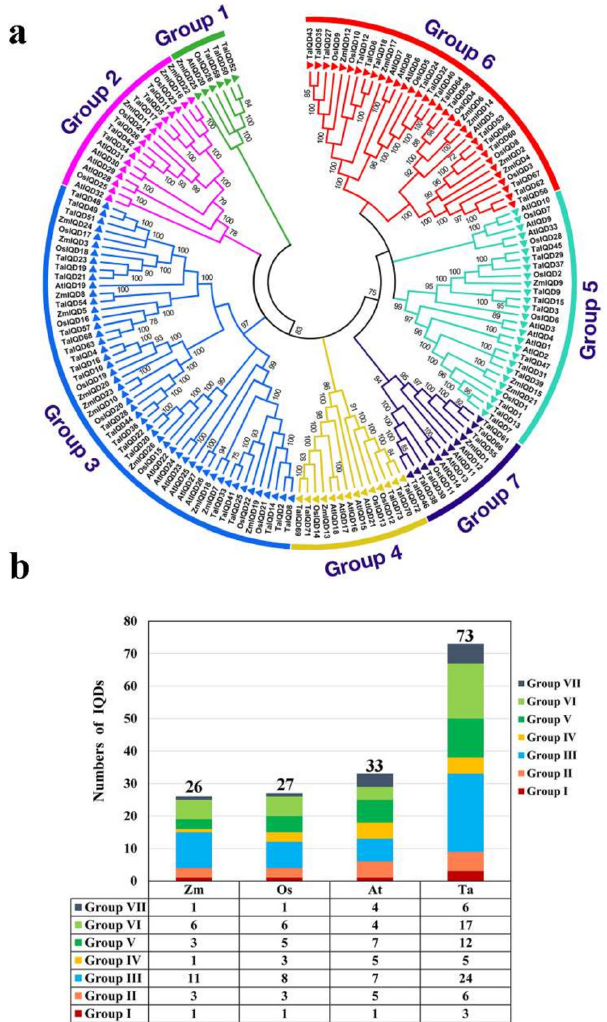
Figure 1. Phylogenetic analysis and distribution of IQ67 domain (IQD) proteins from wheat, Ara- bidopsis, rice, and maize. ( a ) The phylogenetic tree was constructed using the neighbor-joining method. The number of bootstrap values was 1000 replicates. ( b ) Statistics for IQD genes in each group from wheat, Arabidopsis, rice, and